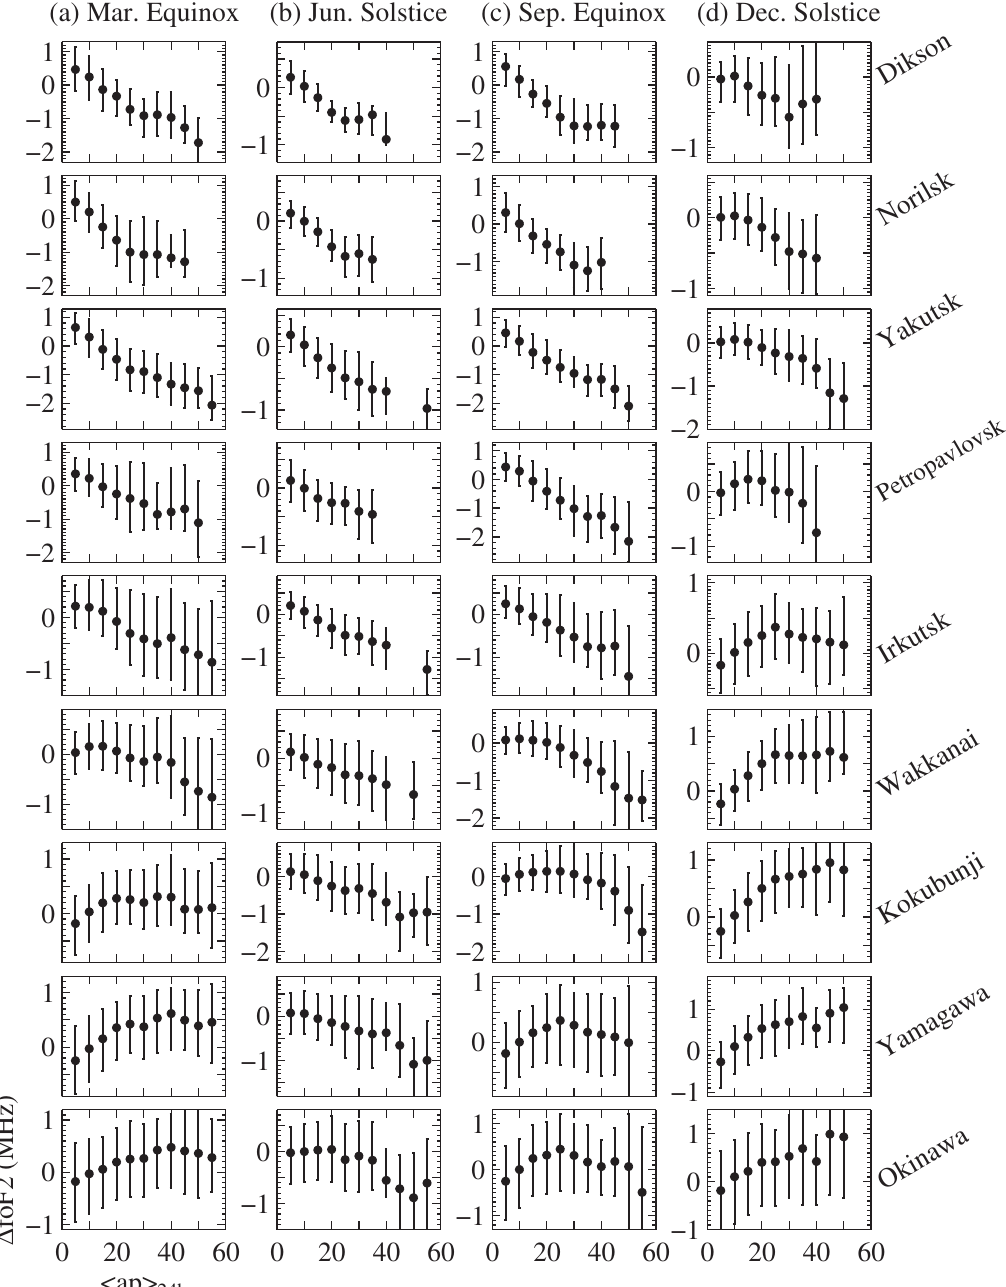
Fig. 4. Variations of the gridded mean D f o F 2 with increasing < ap > 24 h at the northern hemisphere stations (from top to bottom: Dikson, Norilsk, Yakutsk, Petropavlovsk, Irkutsk, Wakkanai, Kokubunji, Yamagawa, and Okinawa); the error bars indicate the lower and upper quartiles of the gridded D f o F 2 . (a – d) present the variations under the seasonal conditions of March equinox, June Solstice, September equinox, and December solstice,